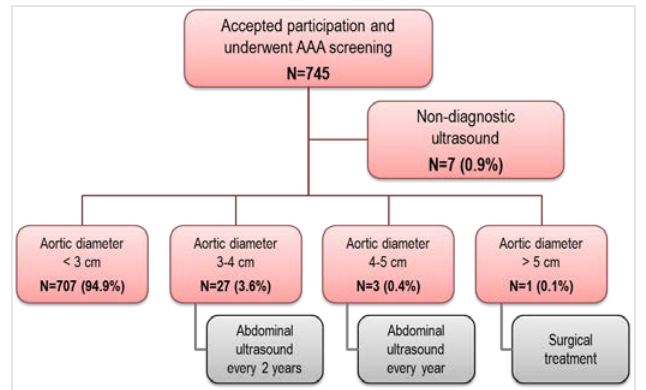
Figure 2: Aortic diameters and subsequent management strategy in the screened patients. AAA = Abdominal aortic aneurysm.